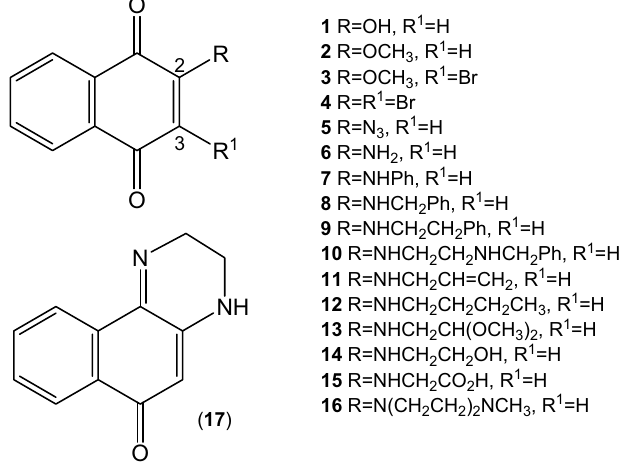
Fig. 1 – Structures of lawsone 1 and derivatives 2-17